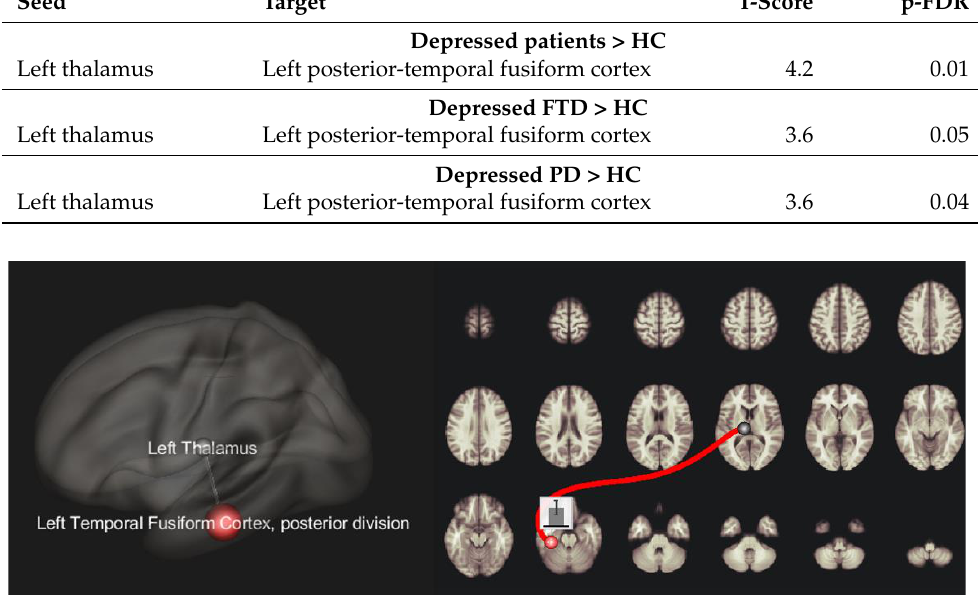
Figure 1. fMRI seed-to-seed 3D representation showing the hyperconnectivity between left thalamus and left posterior temporal fusiform cortex.